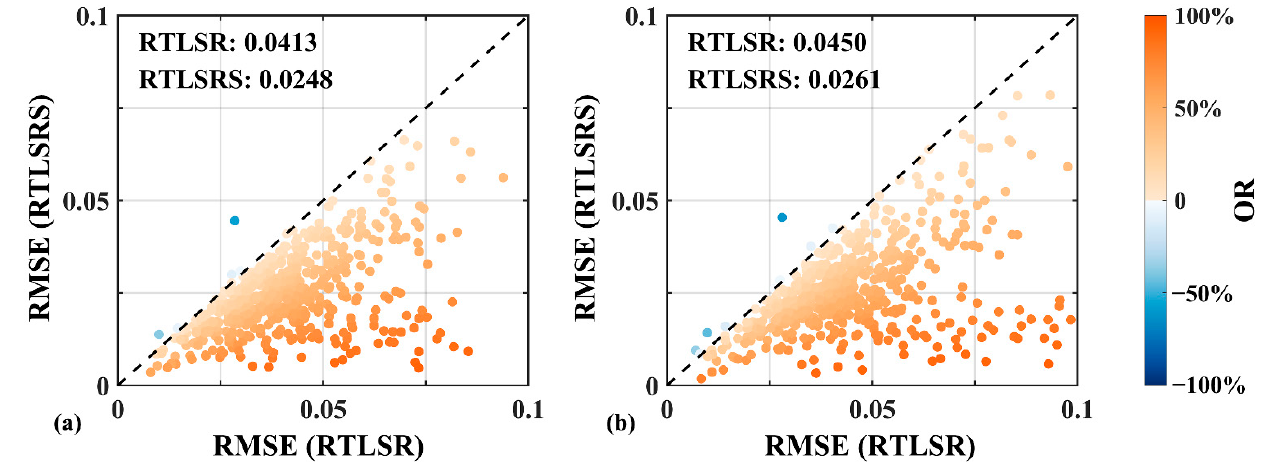
Figure 7. Comparison results of the RTLSR and RTLSRS models using data where IGBP is 15 in the POLDER database. Each point represents an observation site. The colors correspond to OR. The horizontal and vertical axes represent the RMSE of the RTLSR and RTLSRS models. The numbers marked in the upper-left corner are the mean RMSE of the RTLSR and the RTLSRS models. ( a , b ) represent the red and NIR bands, respectively.